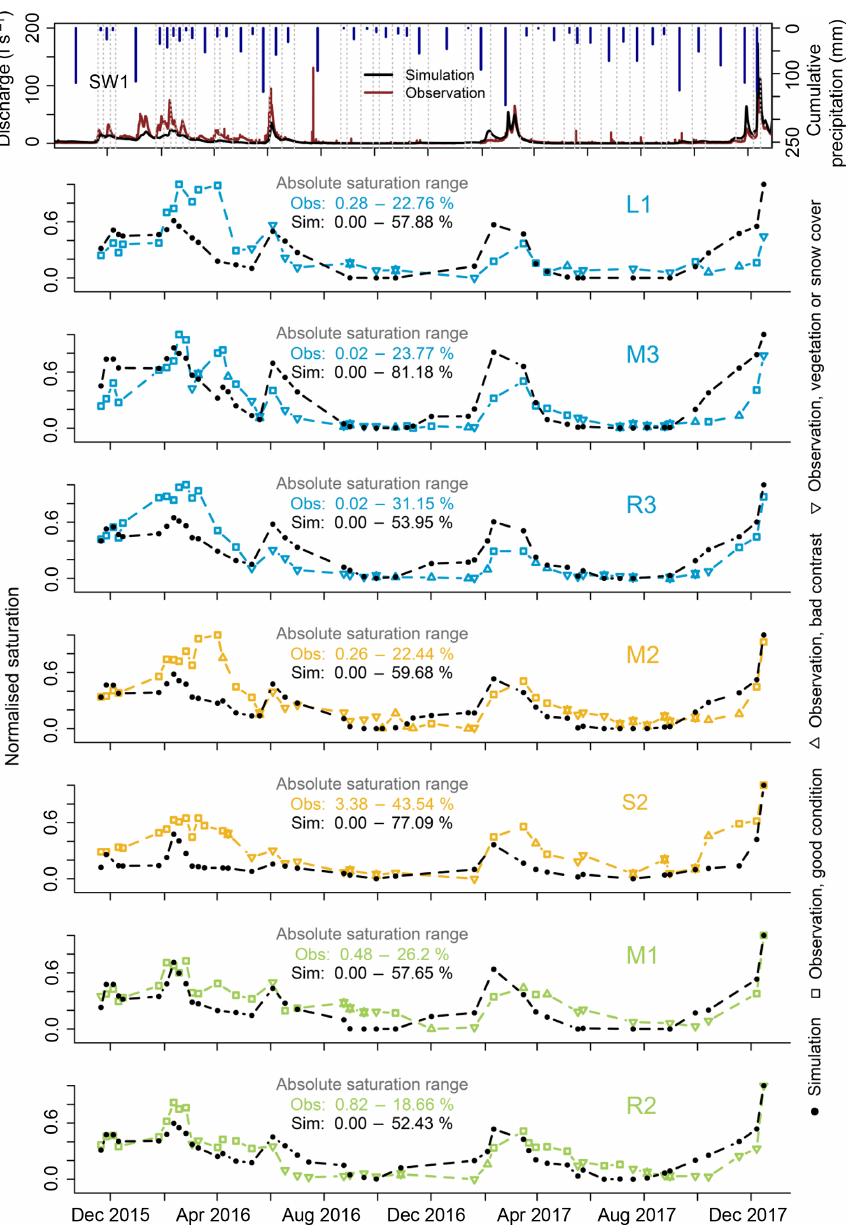
Figure 5. Time series of observed and simulated surface saturation in the seven investigated riparian areas along the left (L1), middle (M1– M3), and right (R2, R3) tributary and the central stream (S2). Colours correspond to the colours of the icons in Fig. 1 and represent the different categories of riparian areas. Surface saturation is normalised to the minimum and maximum amount of saturation that was observed and simulated in the individual areas, respectively. Observations that were derived from TIR images with a poor temperature contrast or with influences of vegetation and snow cover are deemed less reliable and are indicated with triangles (see symbol legend displayed on the right). Cumulative precipitation between the measurement dates (grey dashed lines) and discharge at the catchment outlet SW1 are shown in the top panel to facilitate the comparison to precipitation and flow